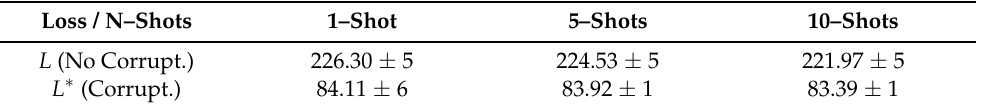
Figure 18. Edge prediction examples obtained post 1–shot test user-adaptation with MAML 2 nd . The top plots show the prediction ˆ x ∗ versus the respiration belt reference, while the bottom plots display the estimated bpm and corruption flag. Legends, which also apply to the plots on the right, are placed in the plots on the left. In ( a ), there are six visible peaks in the belt signal (blue), while in ( b ) there are thirteen peaks. In these examples, the algorithm performs less well than in standard cases. This is mainly due to the lack of edge data as prior knowledge during episodic learning. In the bpm estimation in the example ( a ), a shorter estimate can be seen for the belt than for radar. This is due to the computation of two distinct windows between radar and belt, as explained in Section 3.6. Table 4. MAML 2 nd experiments, average L and L ∗ over the last 300 episodes of test tasks T v evaluation, averaged over 3 repetitions, with 95% confidence